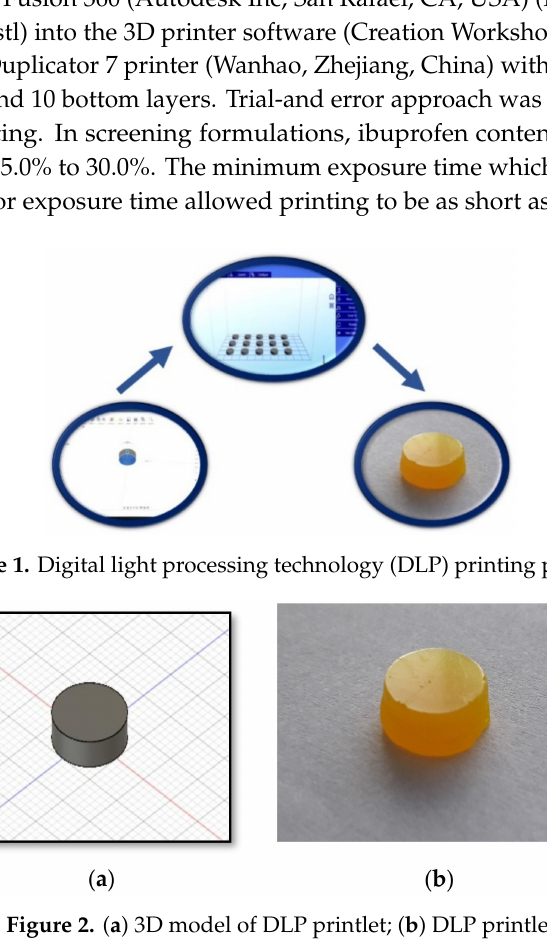
Figure 1. The template used to print the printlets (a cylinder, 10.00 mm diameter, 3.02 mm height) was